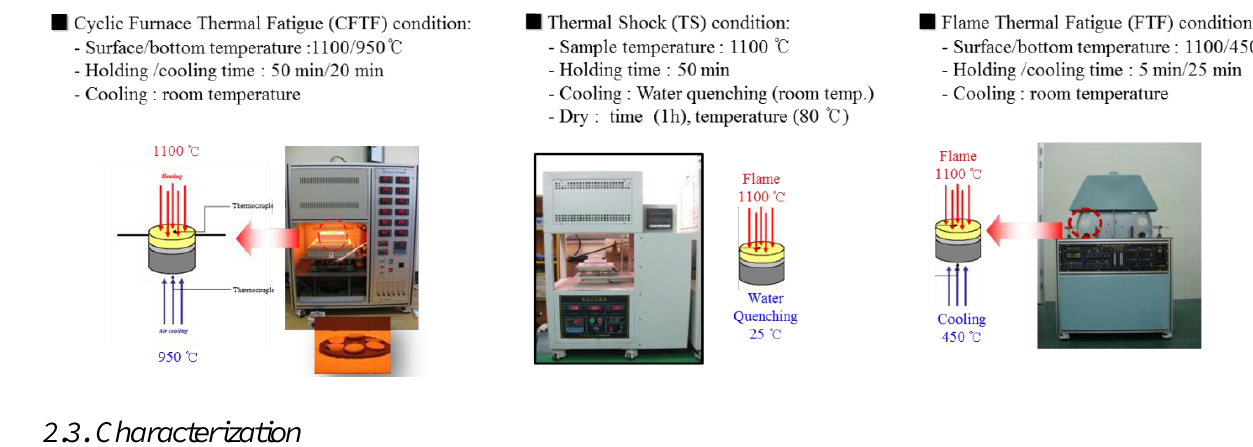
Figure 1. Photos of each test apparatus: Cyclic furnacec thermal fatigue (CFTF), thermal shock test (TS), and flame thermal fatigue